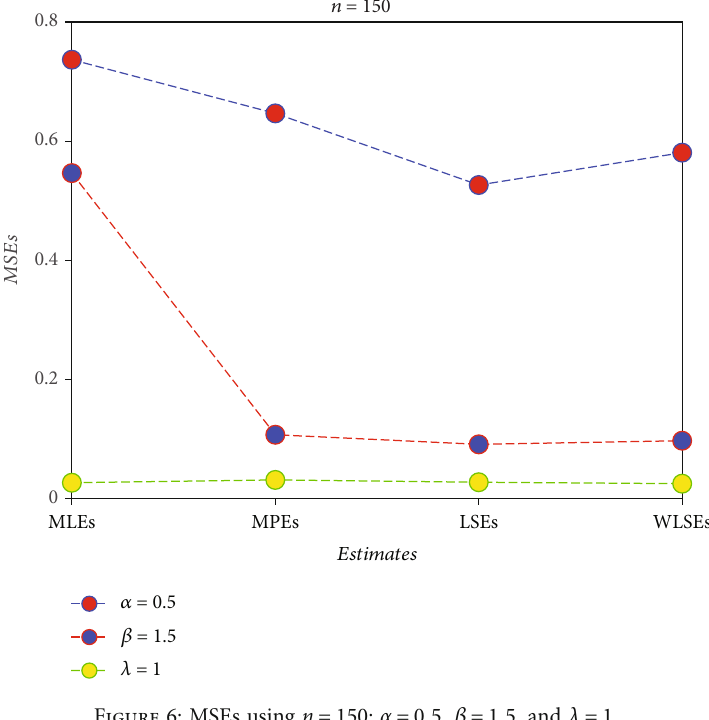
Figure 6: MSEs using n = 150 : α = 0 : 5 , β = 1 : 5 , and λ = 1 .